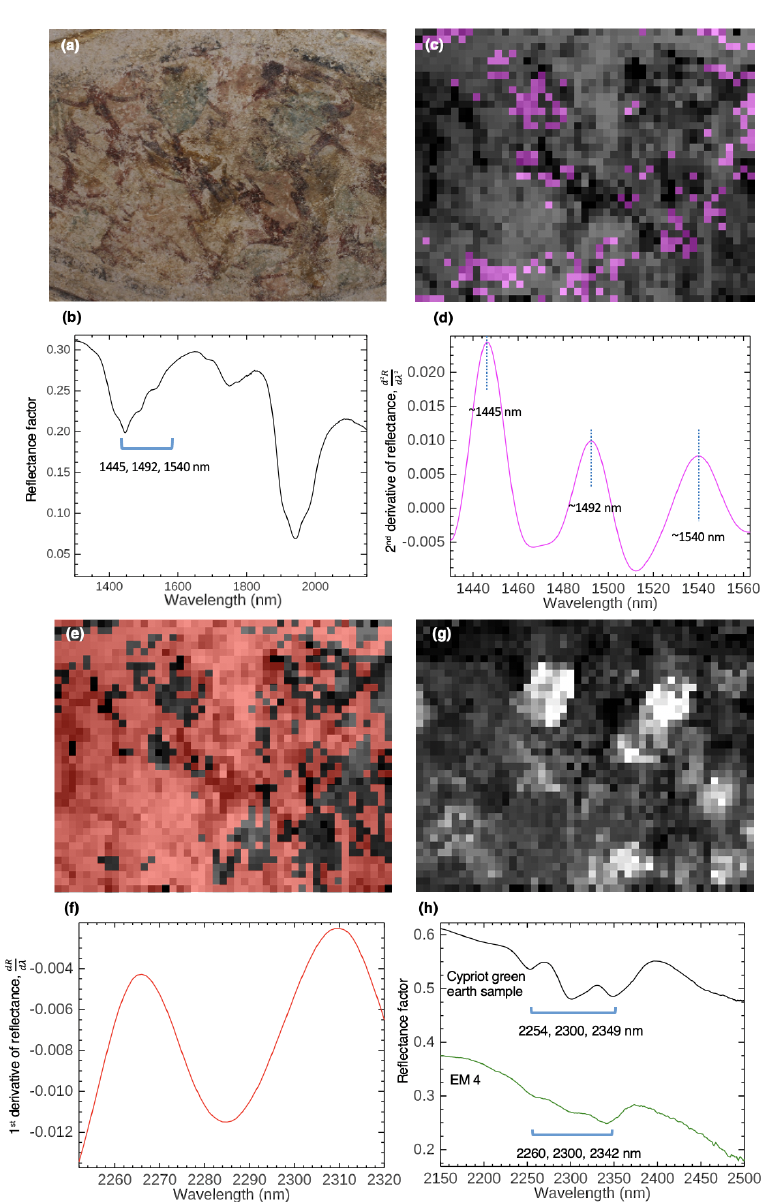
Figure 8. ( a ) Color image of the scan region of Imitation marble . ( b ) A SWIR spectrum from the reflectance image cube showing evidence of gypsum, identified by the triplet absorption from 1445 to 1540 nm and the water bands from 1940 to 1990 nm. ( c ) The SAM map of gypsum’s triplet signature (in magenta) using an endmember extracted from the second derivative-calculated cube subset from 1430 to 1563 nm (plotted in ( d )), overlaid onto a greyscale image from the reflectance image cube. ( e ) The SAM map of PVA application over the surface of the painting (in red) using a first derivative endmember (plotted in ( f )), overlaid onto a greyscale image from the reflectance image cube. ( g ) The MNF eigenimage from the PCA transform of the three broad spectral band images calculated from the SWIR portion of the image cube that shows the distribution of celadonite (in white). A reference SWIR spectrum from a local Cypriot green earth sample and the SWIR portion of EM 4 are in ( h